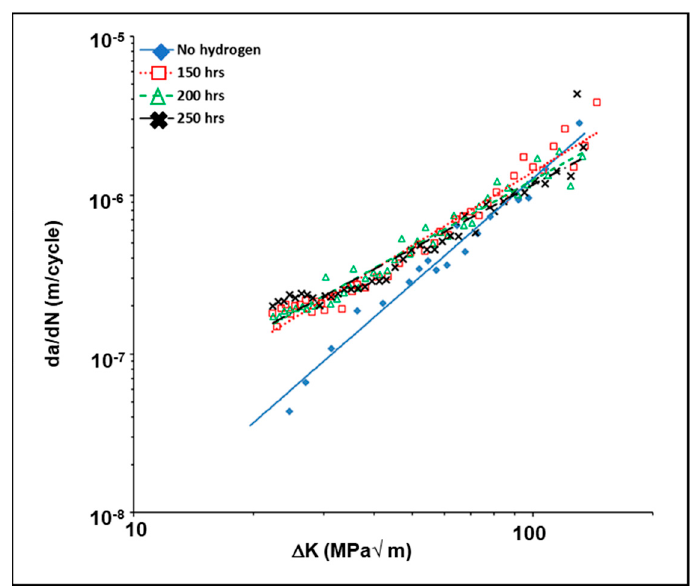
Figure 8. The Effect of Hydrogen Charging Time on the Fatigue Crack Growth Rate in the Linear Region for the Austempered 4140 Steel Samples. Table 7. The Effect of Hydrogen-Charging Time on the ∆ K th for the 4140 Steel Alloy.